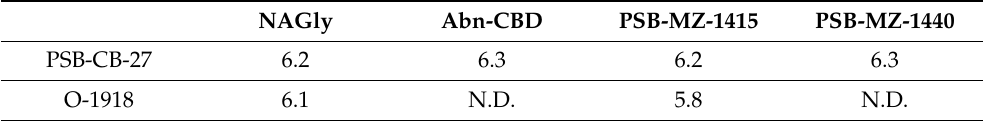
Table 2. Apparent pA 2 values of PSB-CB-27 and O-1918 for their interaction with NAGly, Abn-CBD, PSB-MZ-1415, and PSB-MZ-1440.